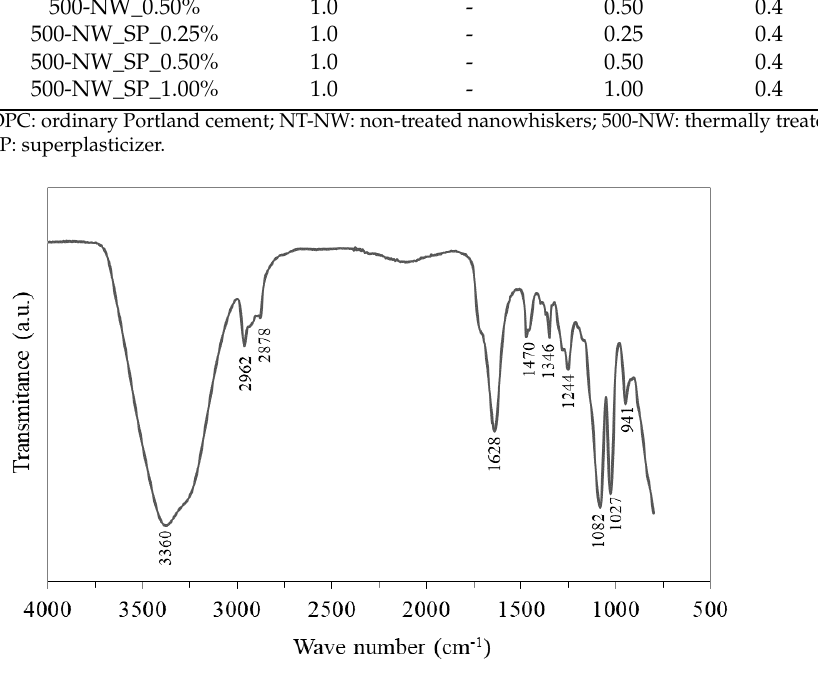
Figure 2. ATR-FTIR spectrum of the SP